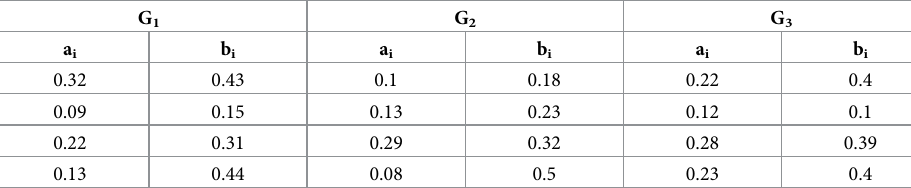
Table 1. The gold mines data of characteristic C 1 . G